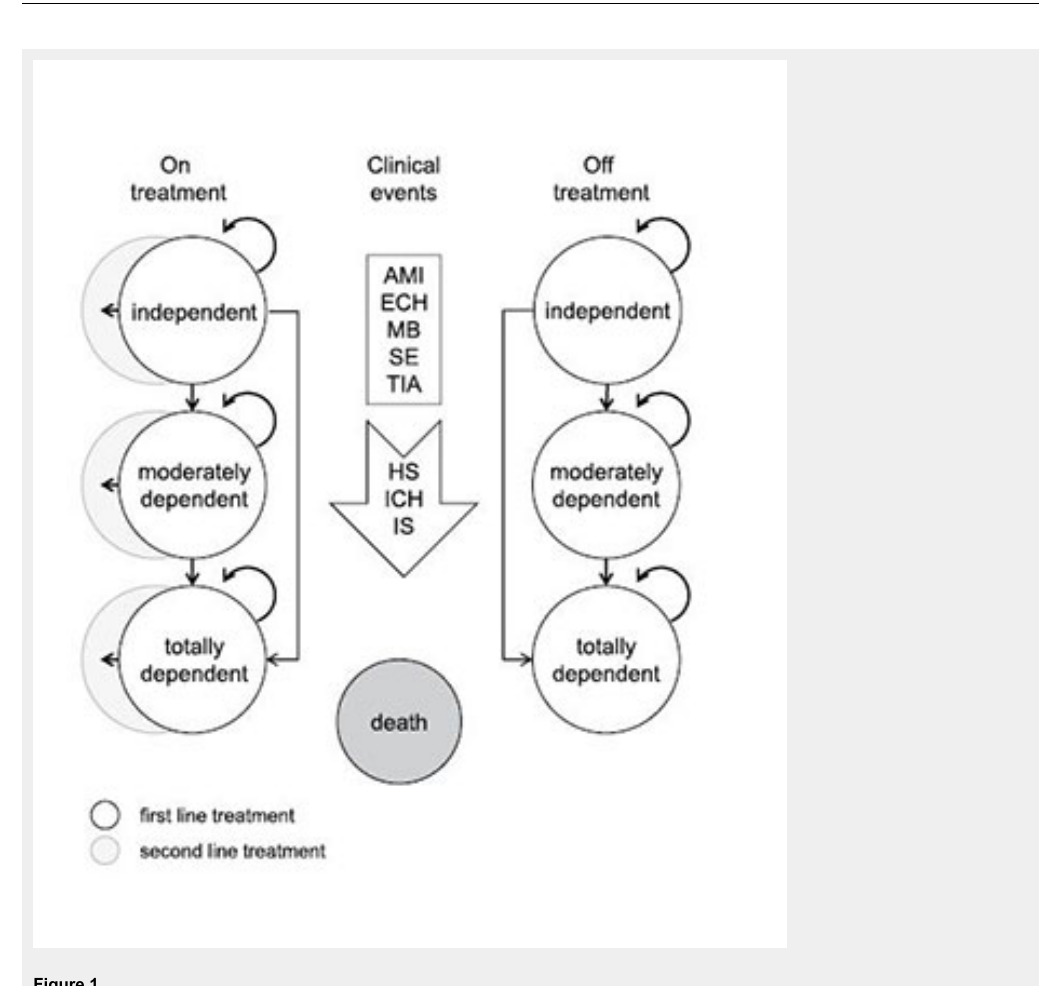
Simplified representation of Markov model. Health states are modelled in 3-month cycles in which a patient may experience no event, a clinical event, or death. All clinical events induce one-time treatment costs and a temporary loss of quality of life. IS, HS, and ICH may lead to permanent disability (moderate or total) causing long-term follow-up costs and a permanent loss of quality of life. Disability levels can only get worse and never improve. After a haemorrhagic event, 50% of the patients are assumed to discontinue treatment. Without any event, the time until treatment discontinuation is modelled by a Weibull hazard function based on data from the RE-LY trial. After treatment discontinuation, 70% of patients on dabigatran and 78% of patients on VKA are assumed to use ASA as a second line treatment. AMI = acute myocardial infarction; ECH = extra-cranial haemorrhage; HS = hemorrhagic stroke; ICH = intracranial haemorrhage, IS = ischemic stroke; MB = minor bleed; SE = systemic embolism; TIA = transient ischemic